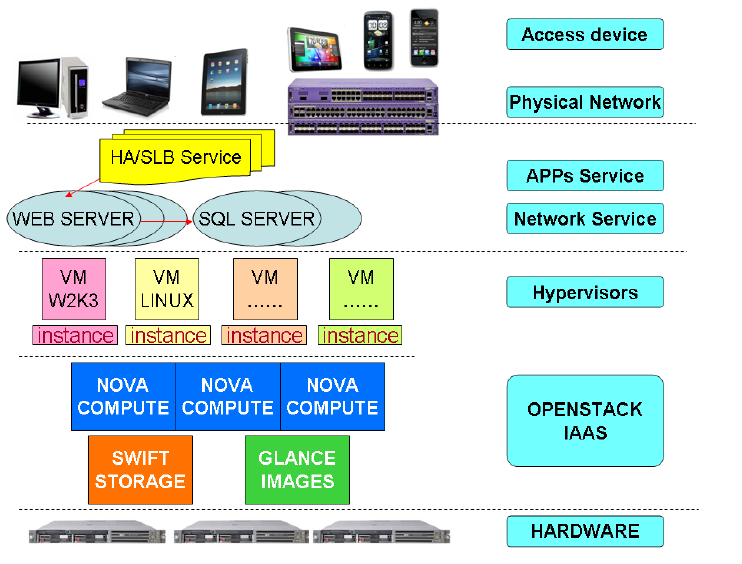
Figure 9. Our cloud e-book hub system